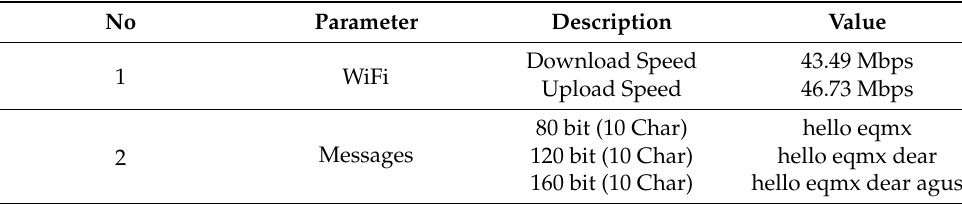
Table 2. Test Parameters.